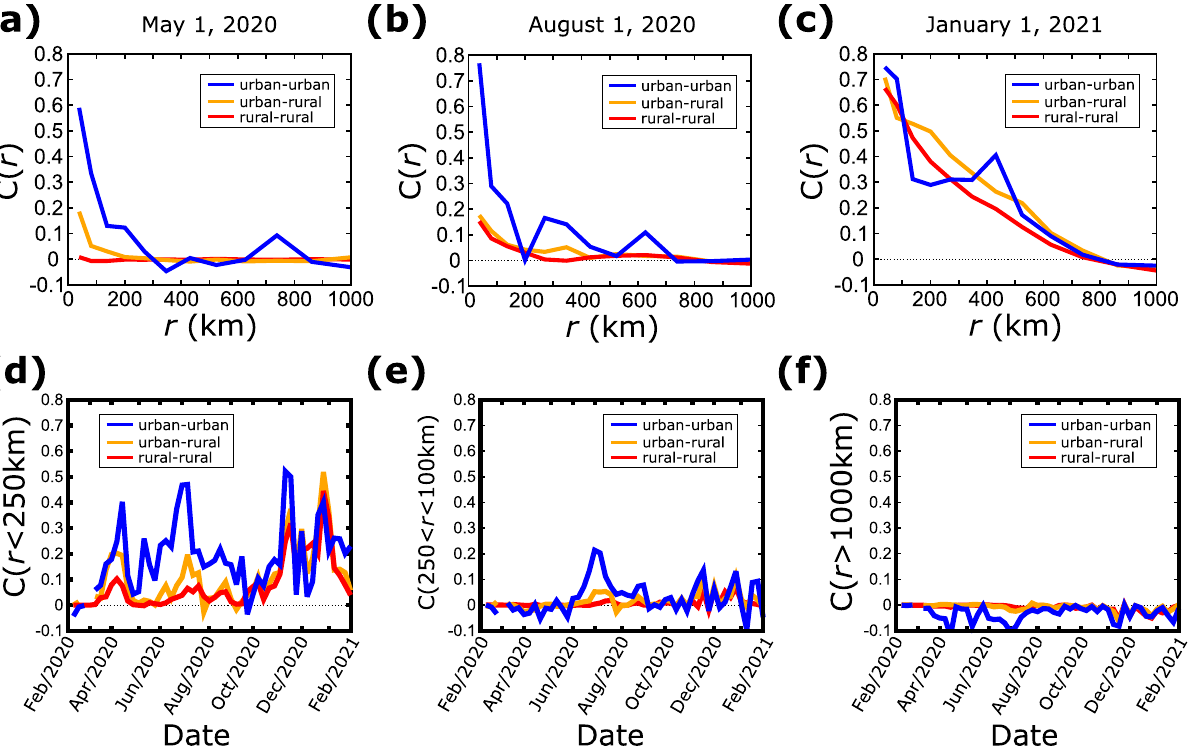
Figure 4. Spatial correlations between areas of different population ( a – c ) Correlation function C(r) between urban–urban, urban–rural, and rural–rural counties, as a function of the distance at three different times. ( d ) Average correlation function between urban–urban, urban–rural, and rural–rural counties which are within 250 km from each other, as a function of time. ( e ) Same plot as in ( d ) for county distances between 250 and 1000 km. ( f ) Same plot as in ( d ) for distances longer than 1000